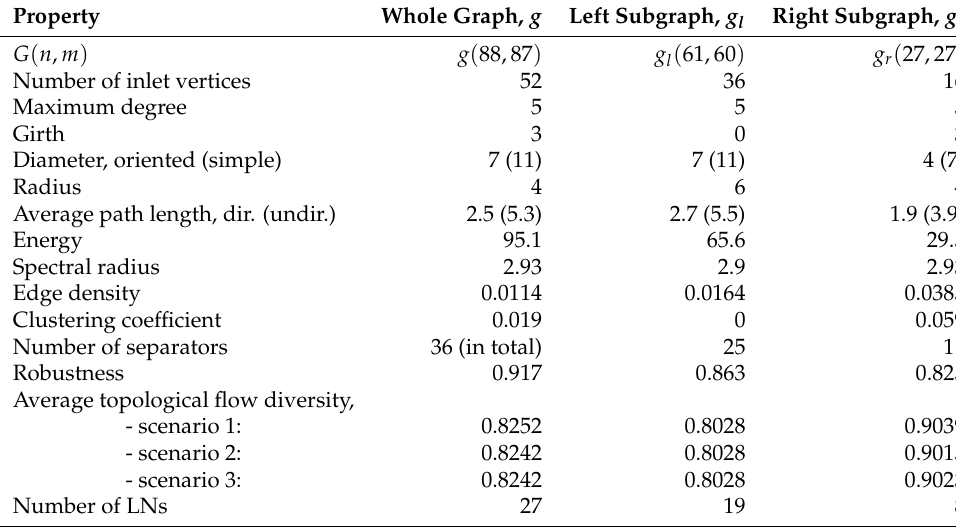
Table 2. Summary statistics for the anatomy-based graph of murine lymphatic system. Property Whole Graph,